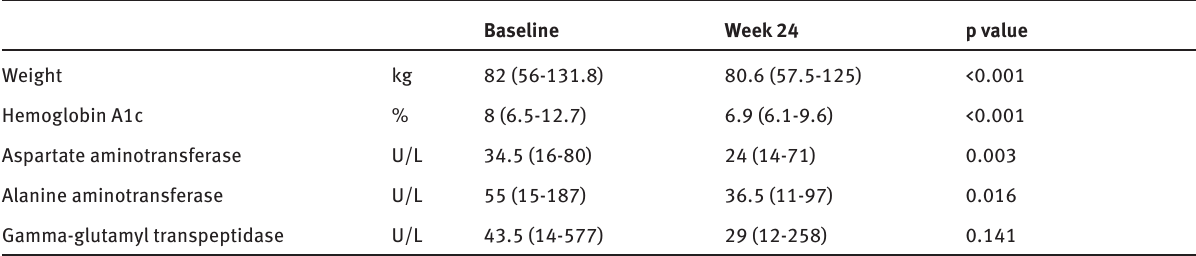
Table 5: The effect of ipragliflozin in 31 patients with non-alcoholic fatty liver